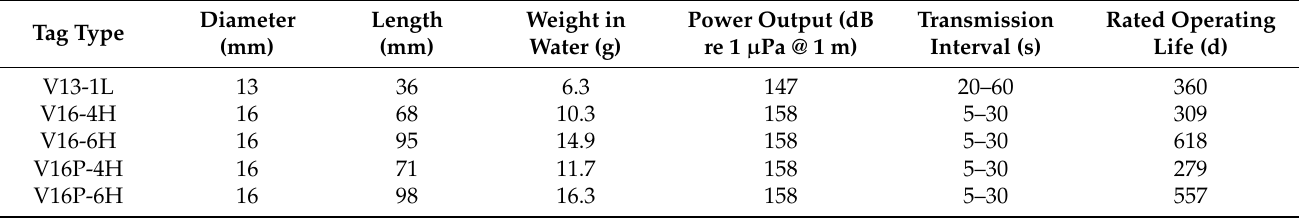
Figure 3. Photos of the fish capture and tagging process for acoustic telemetry tracking in the Mekong River, Thailand and Lao PDR. ( a ) Capture of a B. yarrelli . ( b ) Acoustic tags used in the study. ( c ) A fish anesthetized in the tagging cradle. ( d ) A H. wyckioides in the recovery tote showing the external tag. Table 2. Vemco acoustic tag specifications and operating parameters. The transmission interval shows the minimum and maximum time intervals between transmission bursts; the tag randomly varies the transmission interval in order to maximize both detection probability and battery life. All tags operated at a frequency of 69 kHz.